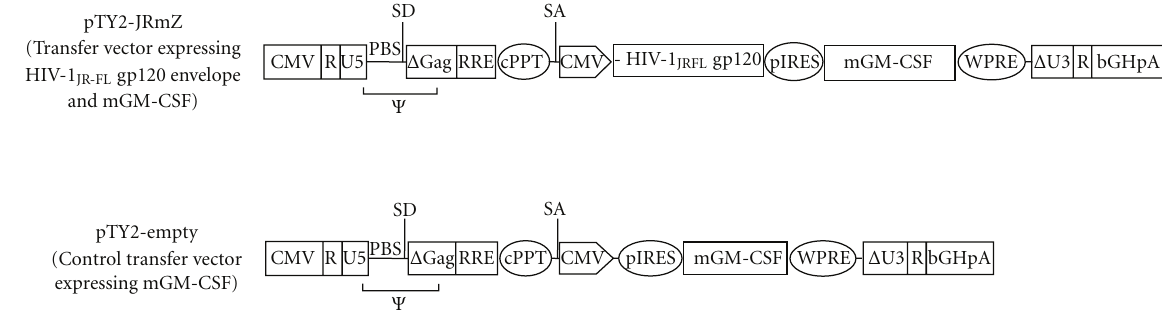
Figure 1: HIV-based transfer vectors plasmid used in this study. The internal CMV promoter drives the expression of the codon-optimized HIV JR-FL gp120 Envelope protein and the murine GM-CSF (mGM-CSF). The packaging signal ( Ψ ), primer binding site (PBS), major splice donor (SD) and acceptor (SA) sites, bovine Growth Hormone polyadenylation signal (bHGpA), central polypurine tract (cPPT), internal ribosomal entry site from poliovirus (pIRES), and Woodchuck posttranscriptional regulatory element (WPRE) are